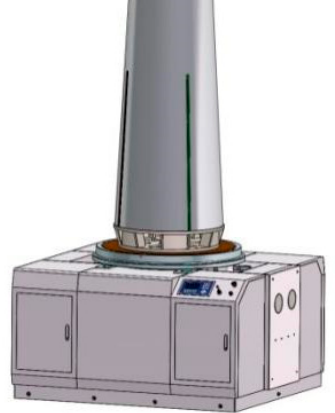
Figure 8. Aircraft mass centroid measurement diagram.